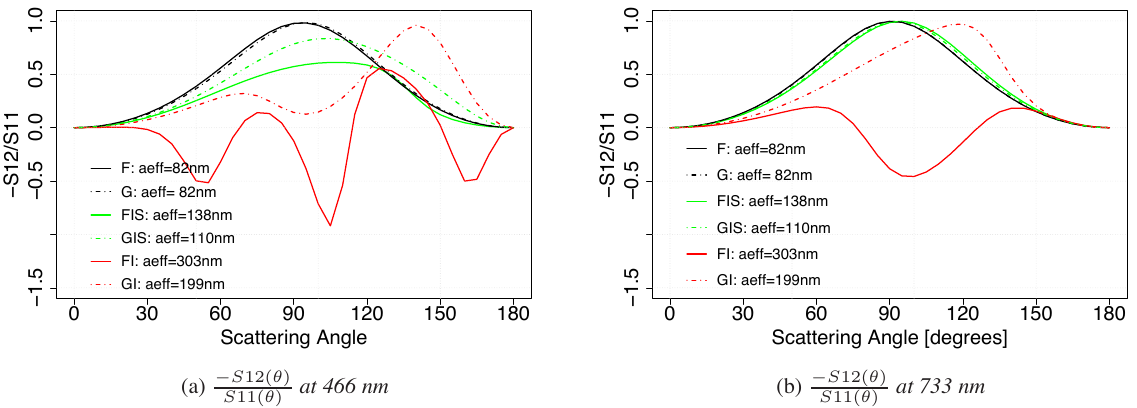
Fig. 9: Degree of linear polarization at 466 nm (a) and 733 nm (b). Characteristics of the bare BC (cases F and G) and mixed BC-NaCl (cases FI, GI, FIS, and GIS) are described in Table 2 and Figures 5,6. 733 nm, the particles with a eff between 82 and 130 nm exhibit bell shape curves (Rayleigh regime), whereas larger